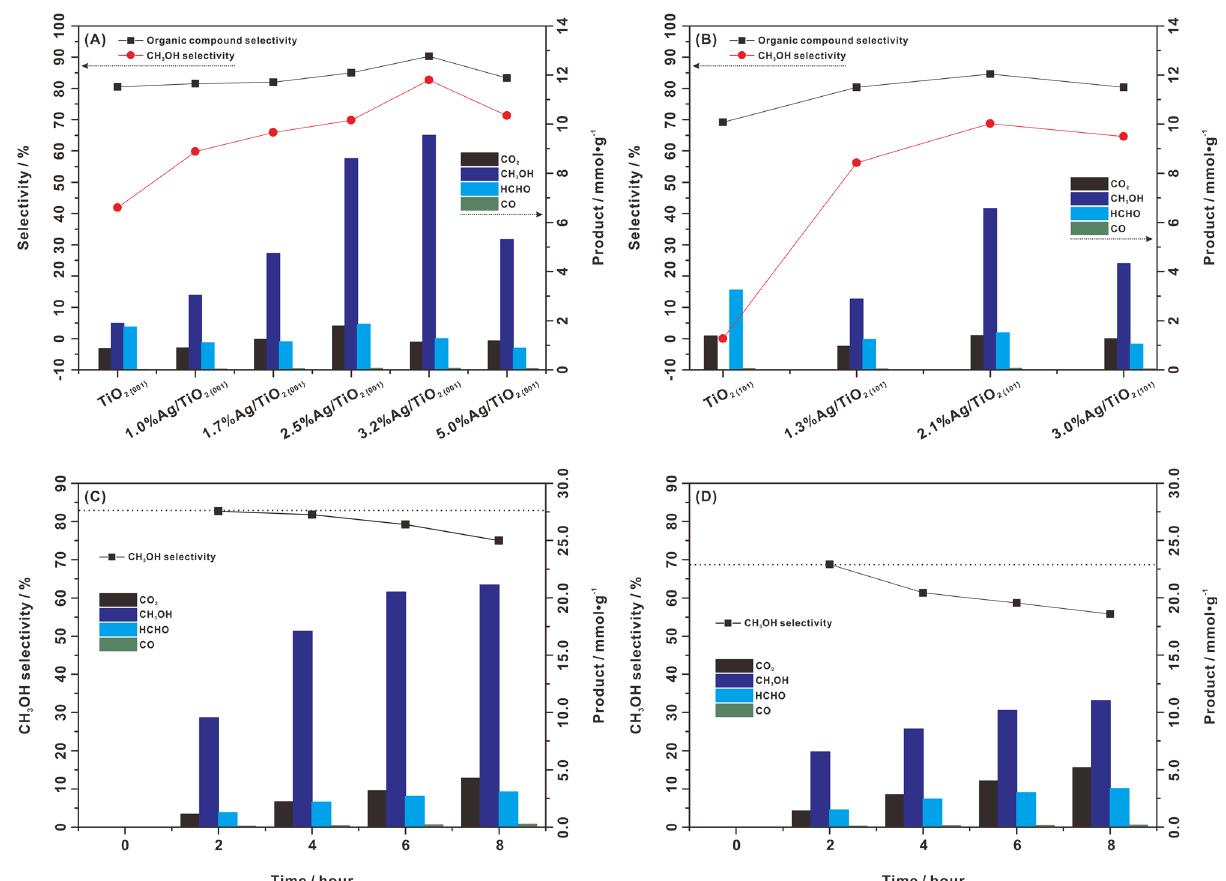
Fig. 1 Photocatalytic CH 4 conversion with molecular O 2 . CH 3 OH selectivity and product yields for a series of Ag-loaded TiO 2 photocatalysts with predominantly exposed A {001} facets (0 – 5.0%Ag/TiO 2 {001} ) and B {101} facets (0 – 3.0%Ag/TiO 2 {101} ) under 2 h of irradiation. Time course for CH 3 OH selectivity and product yields for C 3.2%Ag/TiO 2 {001} and D 2.1%Ag/TiO 2 {101} under irradiation. Reaction conditions: 10 mg Ag/TiO 2 , 100 mL water,